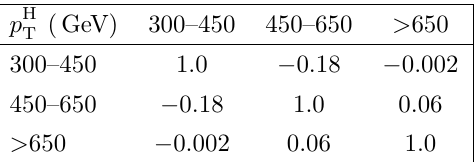
Table 5 . Correlation coefficients between the three p H section